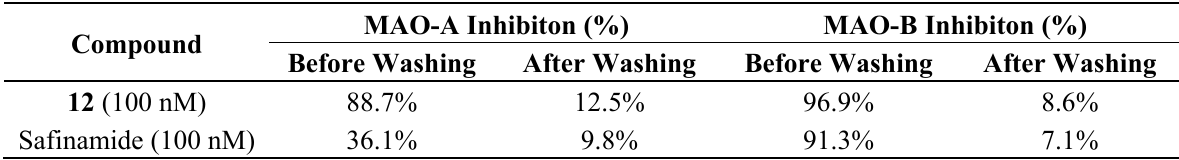
Table 3. Reversibility of MAOs inhibition with 12 and Safinamide.